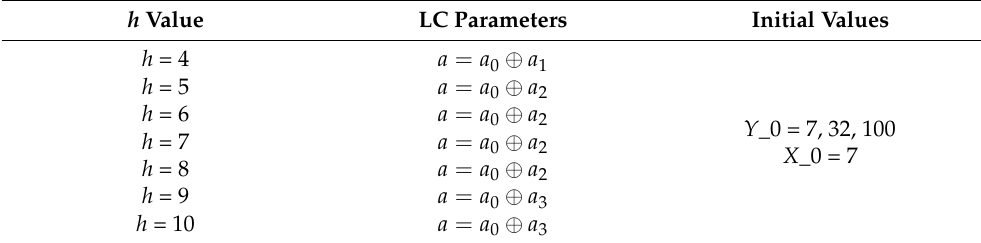
Table 4. Parameters of the combined